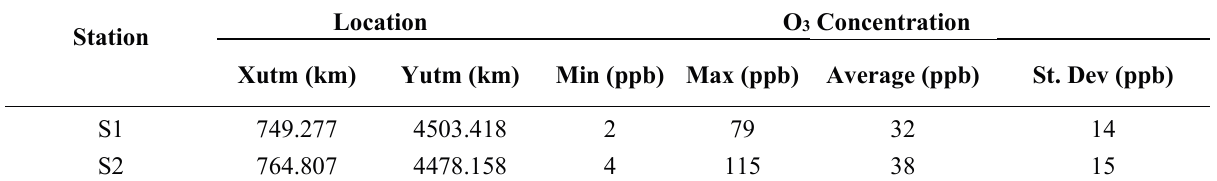
Table 1. Location, minimum, maximum, average and standard deviation of hourly O 3 concentration measurements at two monitoring stations located within the simulation domain. Year 2006.